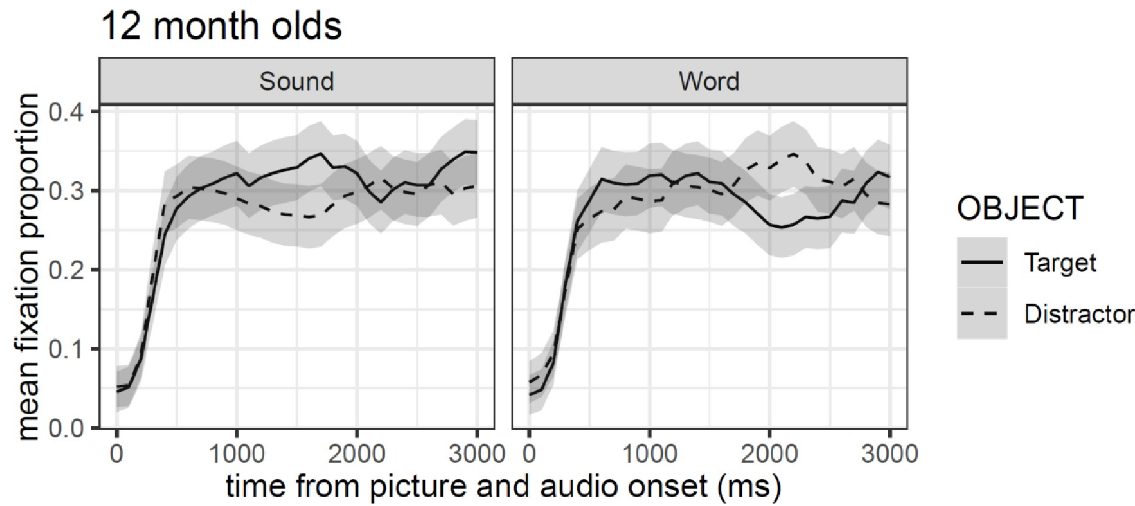
Fig 7. Mean fixation proportion (aggregated by participants) as a function of object in the visual context and type of auditory stimulus. Shaded areas around lines represented 95% confidence intervals adjusted for within-subject designs and multiple time windows.